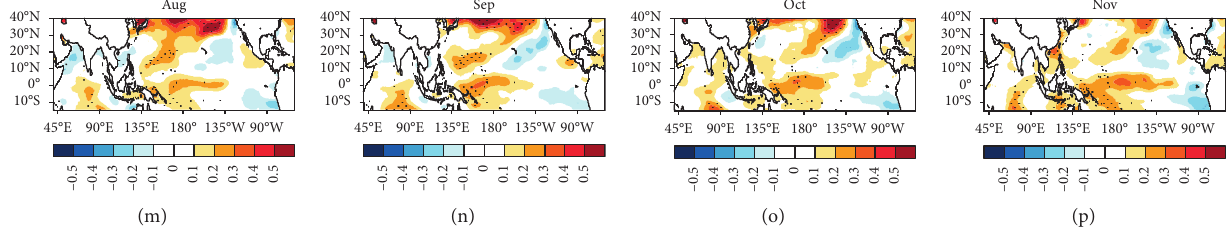
Figure 13: Composite monthly SSTAs (shading; (K)) from April to November between late-onset years of the period of 1979–1993 (left) and early-onset years of the period of 1994–2016 (right). Thick solid lines surround the region exceeding the 90% confidence level, respectively. (a, i) Apr, (b, j) May, (c, k) Jun, (d, l) Jul, (e, m) Aug, (f, n) Sep, (g, o) Oct, and (h, p)